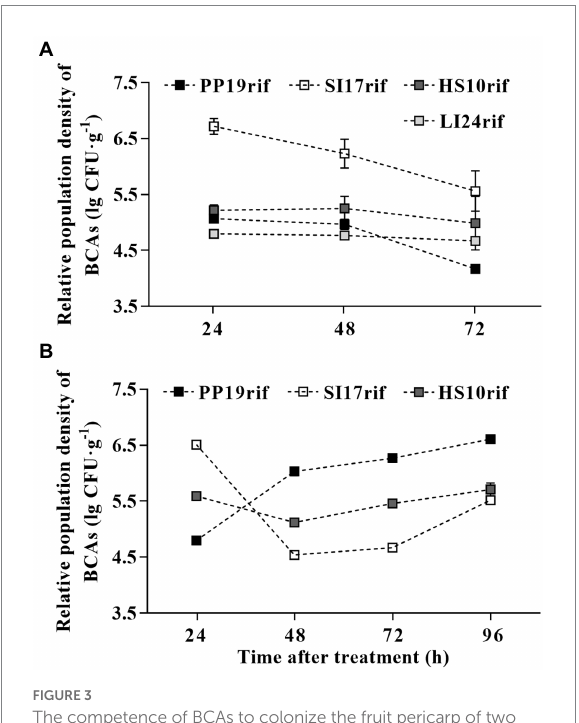
FIGURE 3 The competence of BCAs to colonize the fruit pericarp of two litchi cultivars ‘Feizixiao’ and ‘Huaizhi’ in FLT2017-2. The population densities of PP19rif, SI17rif, LI24rif, and HS10rif in ‘Feizixiao’ (A) and ‘Huaizhi’ (B) fruit pericarp over time. The fruit samples (about 65% ripeness) were sprayed with a bacterial suspension (5 × 10 7 CFUs mL − 1 ) in the field in Danzhou (Hainan province) and Guangzhou (Guangdong province). After 7 days, the fruits (about 80% or 85% ripeness) were transported to the laboratory, where they were placed in a preserving box and sprayed with the bacterial suspension (5 × 10 7 CFUs mL − 1 ) again. Data are presented as means of replicates ± standard errors; different letters indicate significant differences between treatments according to LSD test at p <